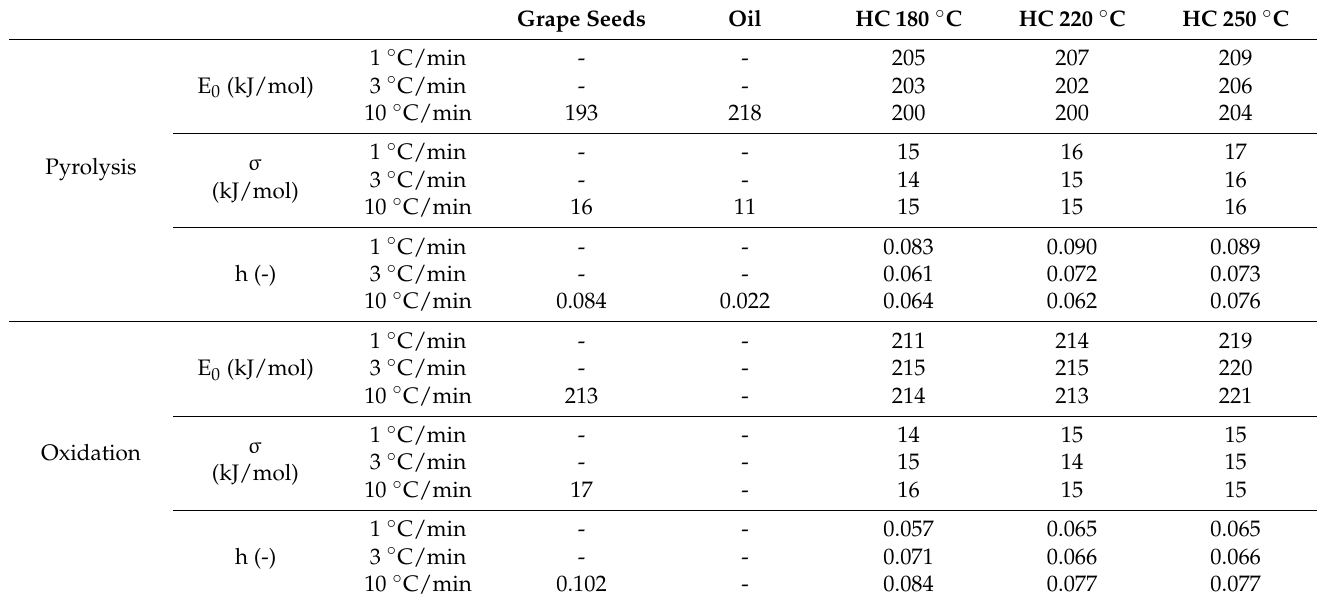
Table 5. Values of E 0 and σ for the Gaussian model for the different substrates and heating rates; per moles of dry feedstock. k 0 is let constant and equal to 1.67 × 10 13 s − 1